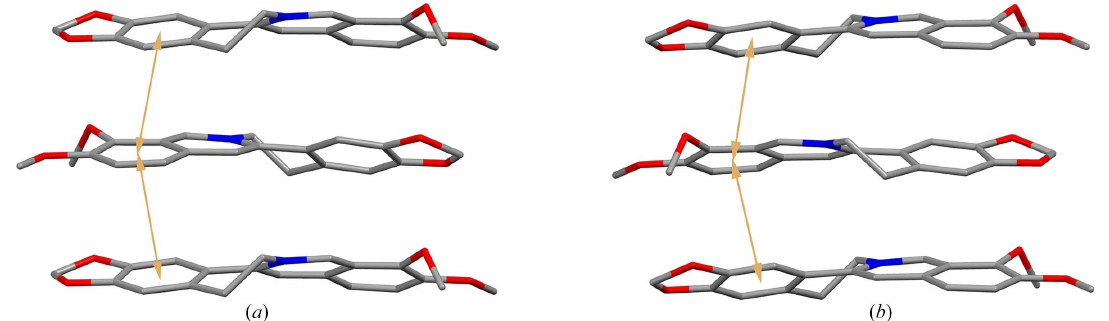
Figure 5 (cid:9) – (cid:9) interactions among molecules in ( a ) 1BER-1 l TA-1W and ( b ) 1BER-1 d TA-1W (hydrogen atoms have been omitted).